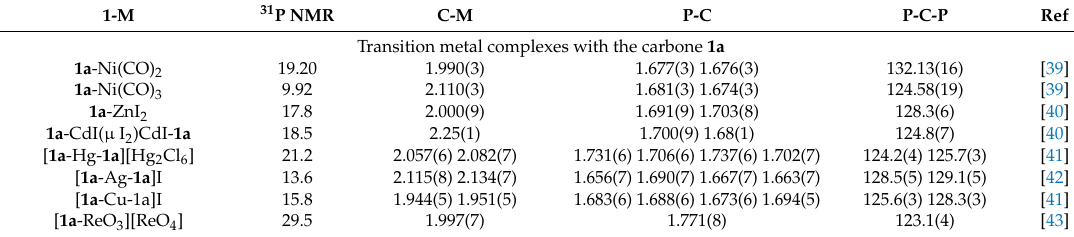
Table 1. Transition metal complexes with the carbones 1a to 1e including C-M and P-C bond lengths and P-C-P angles and 31 PNMR shifts in